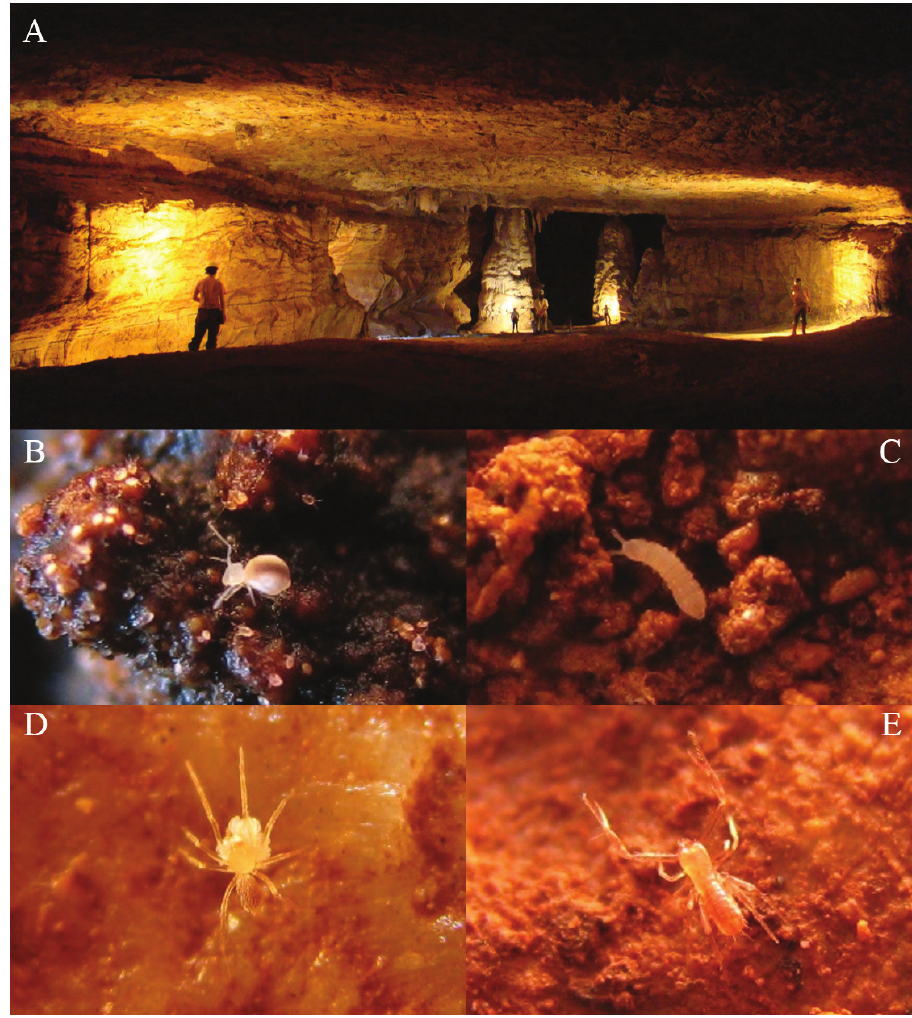
Figure 2. A Passage in Lapa Nova Cave B, C, D, E Examples of troglomorphic species recorded in the Northwest region of the state of Minas Gerais, Brazil. B Collembola: Arrhopalitidae: Arrhopalites sp.1 C Col- lembola: Poduromorpha, Acherontides sp.1 D Araneae: Ochyroceratidae sp.1 and E Pseudoscorpiones: Chthoniidae, Pseudochthonius